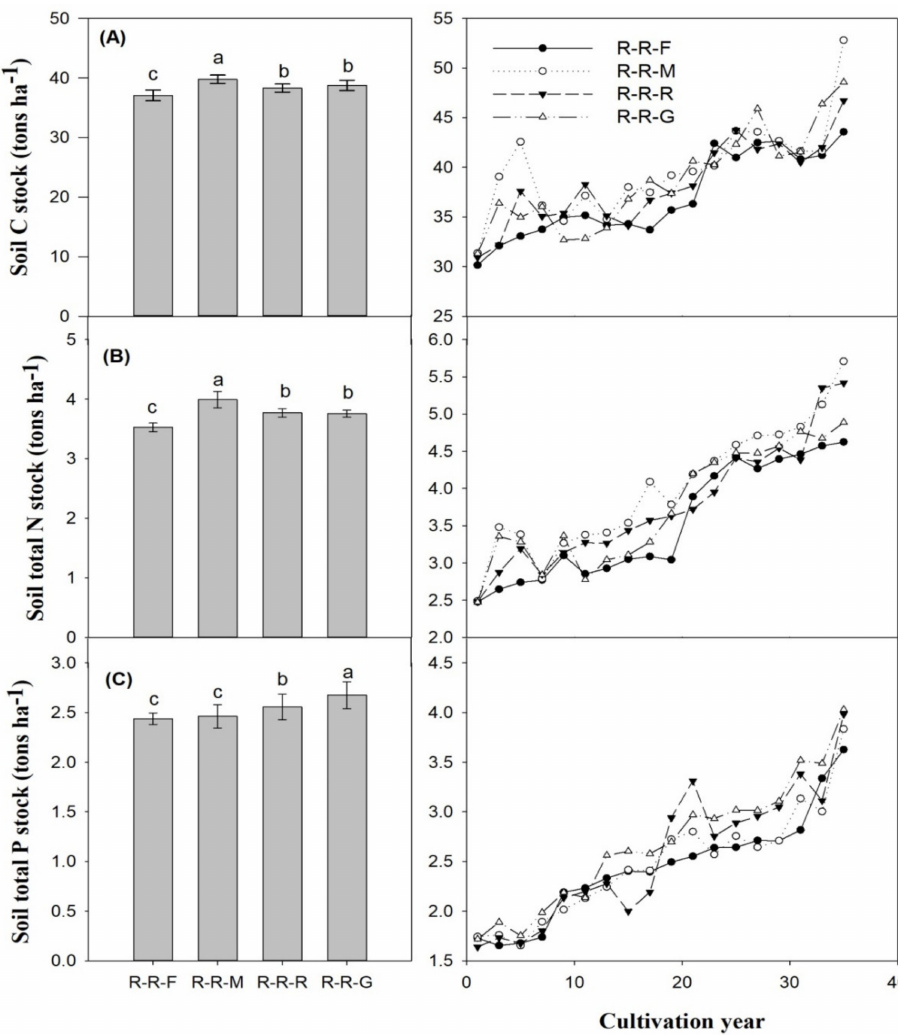
Figure 3. E ff ect of di ff erent long-term green manure rotations on stocks of soil organic carbon ( A ), total N ( B ) and total P ( C ) in acidic paddy soil. Error bars represent ± standard deviations; di ff erent letters over the bars indicate significant ( p ≤ 0.05) di ff erences according to Tukey’s LSD test. GM rotations significantly ( p ≤ 0.05) influenced the annual apparent N and P balance in the long- term experiment on the double-rice cropping system (Figure 4). In the control treatment (R- R- F), the apparent N and P balances were highest compared with those in all other GM treatments. The annual N balance in the R-R-M, R-R-R and R-R-R treatments was decreased by 38%, 21%, and 24%, respectively, and the annual P balance was decreased by 36%, 27%, and 34%, respectively, compared with those of R-R-F in the double-rice cropping